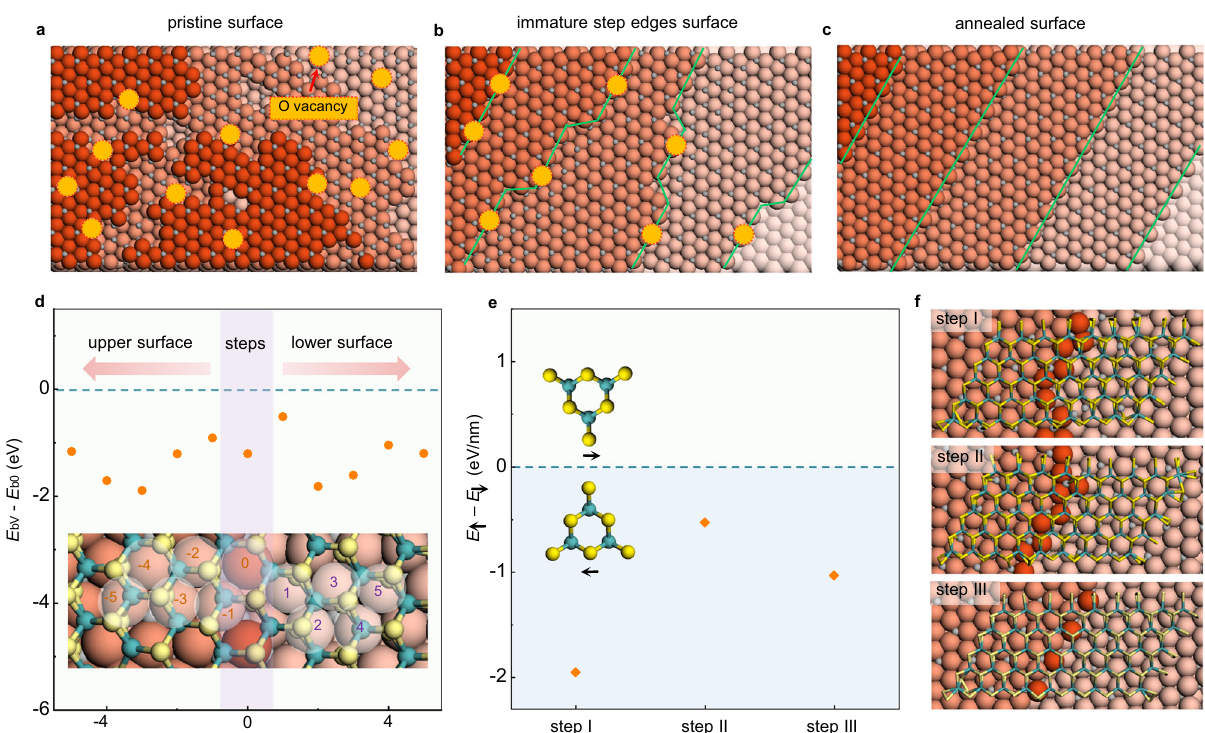
Fig. 4 | Mechanism of the simultaneous-formation-guided epitaxial growth of MoS 2 on vicinal c-Al 2 O 3 . a – c Schematic diagrams of the evolution of the c-Al 2 O 3 surface during annealing at high temperature. a The original c-Al 2 O 3 surface is full ofdisordersandnoclearseparationofstepedgesandterraces. b Duringannealing, oxygenvacancies onterraces weregradually annealed, while some disorders, such as oxygen vacancies, still appeared in the blurred step edges. c After a long annealing time, the substrate is fully reconstructed with ultra- fl at terraces sepa- rated by parallel step edges, and all the disorders on the substrate disappears. The red dotted circles represent the oxygen vacancy. The yellow, green, pink and grey spheresrepresenttheS,Mo,O,andAlatoms,respectively.Thegreenlinesshowthe edges of the steps. d The binding energy difference of a MoS 2 grain on a straight parallel step without O vacancy ( E b0 ) and on a defective step with different O vacancy at different sites ( E bV ). The negative values of ( E bV – E b0 ) reveals a stronger interaction between a MoS 2 grain and the defective steps. Inset: the different